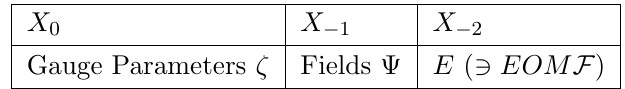
Table 1 . Graded subspaces and the elements they